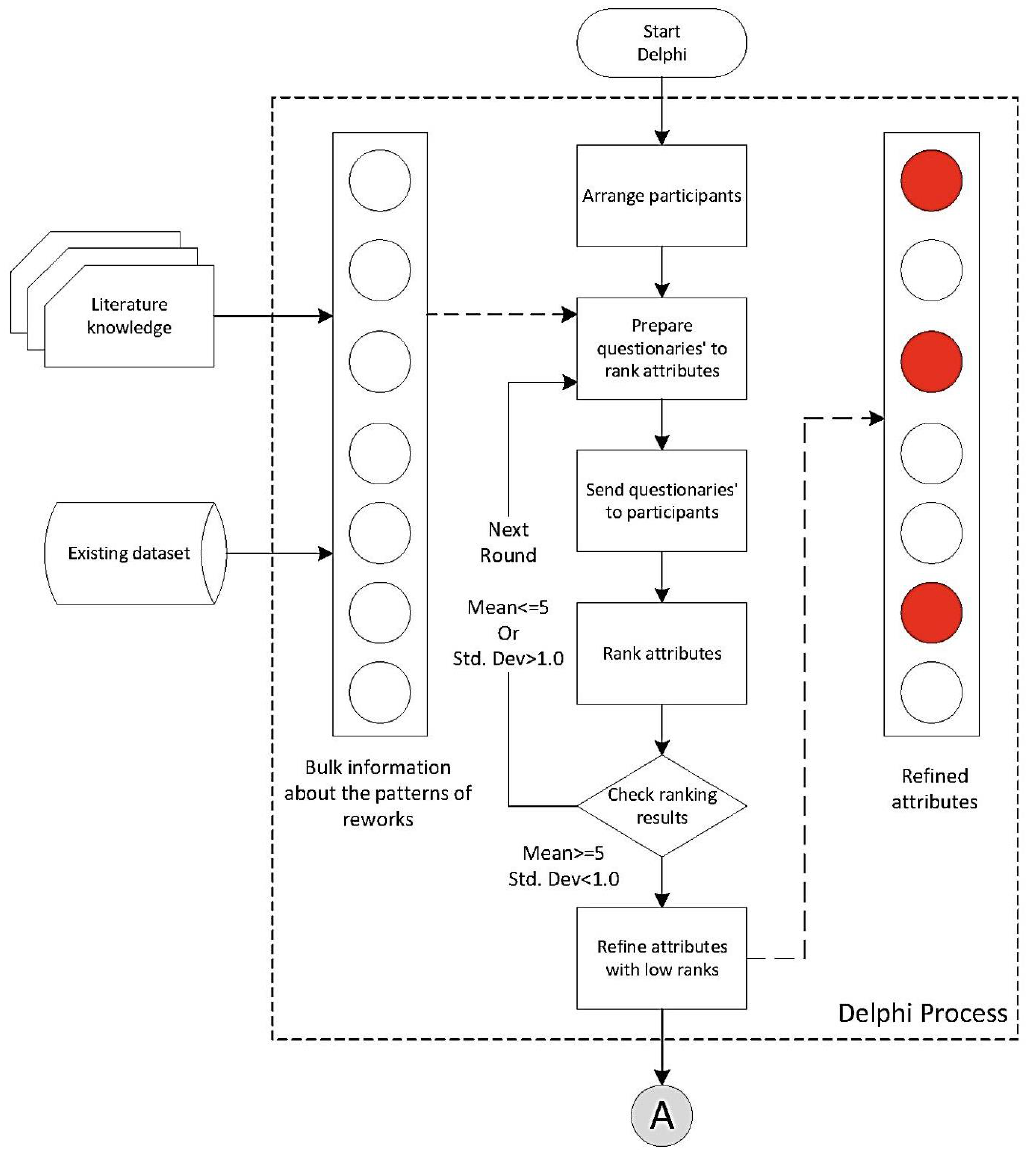
Figure 2. The summary of the Delphi Process [59] .